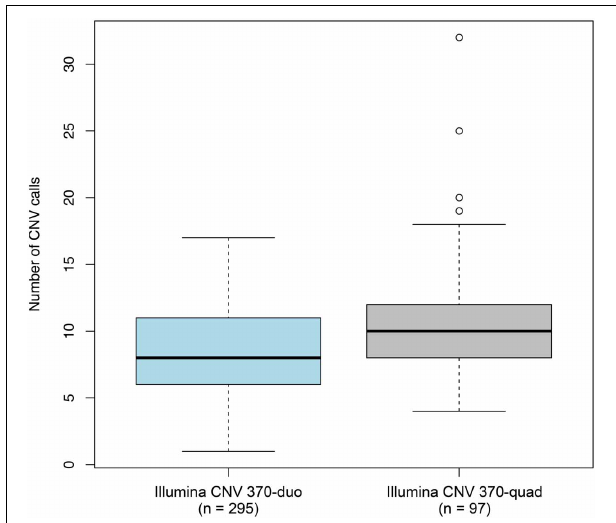
FIGURE 5 | Box-and-whisker plots of the number of CNV calls made between different configurations of the genotyping platform. Whole-genome SNP array genotyping was performed on two different configuration of the Illumina HumanCNV370 bead array: the duo and quad. Based on the final set of 3520 QC-filtered CNV calls, the interquartile range and median number of calls derived from each configuration are represented by a shaded box and black bar, respectively. The whiskers are drawn to 1.5 times the interquartile range; circles are drawn to represent individuals with a total number of CNV calls beyond that range. We observed statistically significant differences in the number of CNVs detected between the two configurations.